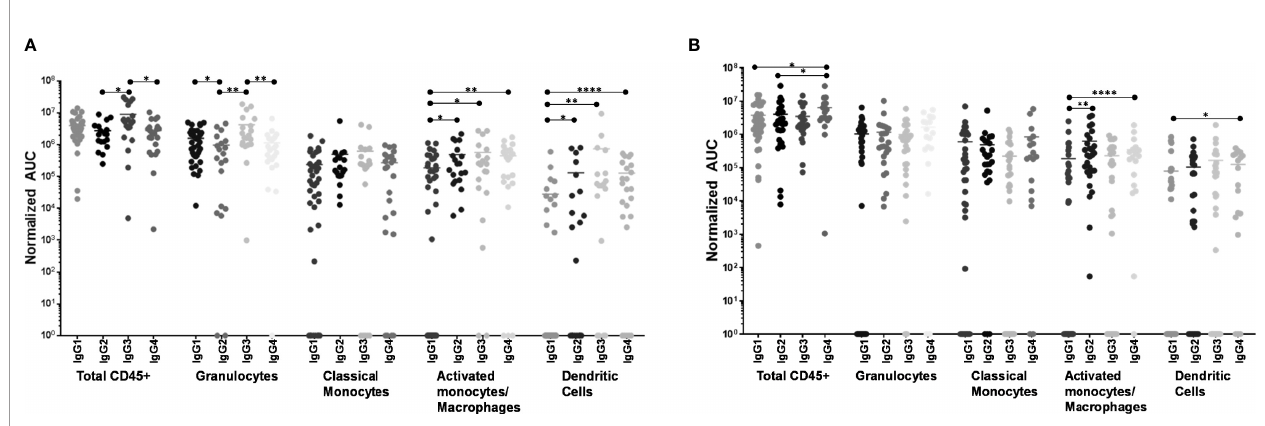
FIGURE 5 | ADCP activity of each phagocyte subset as compared by IgG isotype. (A) Virus ADCP. (B) Immune complex (IC) ADCP. Experiments and analyses were performed as in Figure 4 . ****p < 0.0001; **0.009 > p > 0.001; *0.05 > p